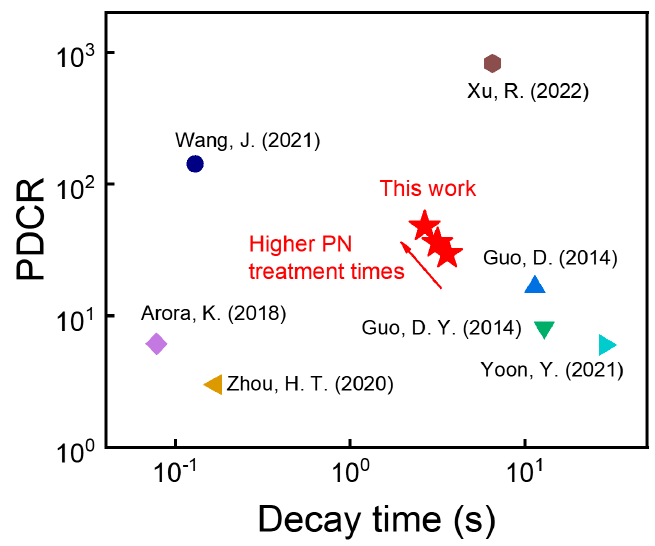
Figure 5. PDCR versus photoresponse decay time of various β -Ga 2 O 3 based MSM PDs. (Yoon, Y.